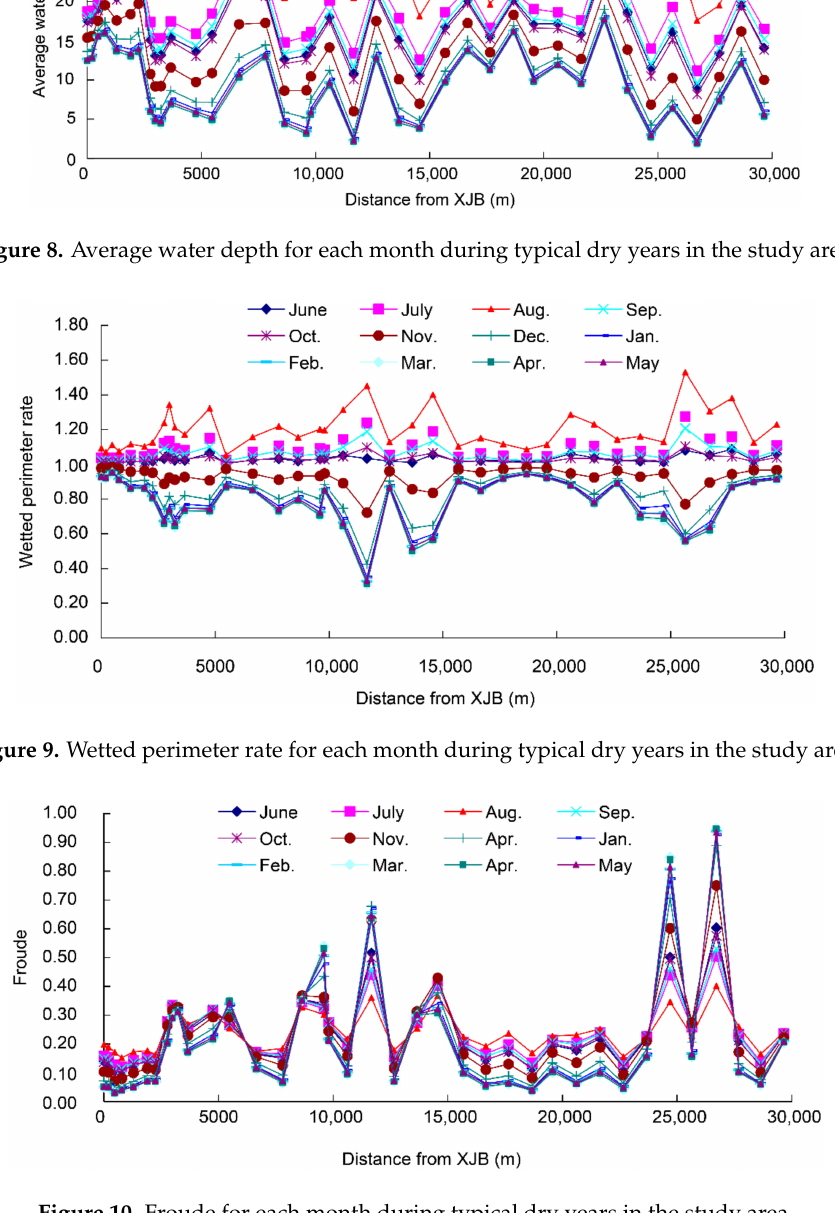
Figure 10. Froude for each month during typical dry years in the study